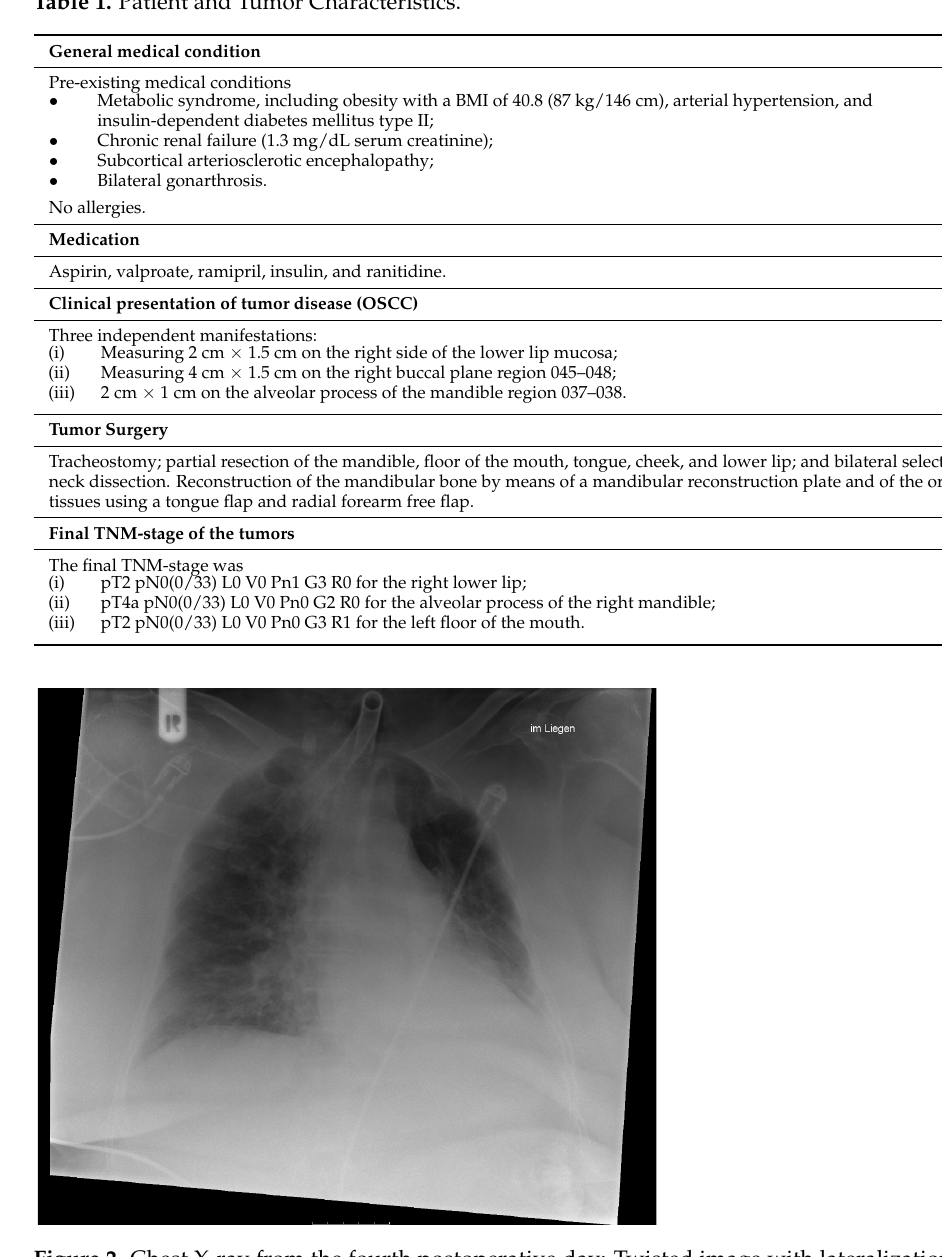
Figure 2. Chest X-ray from the fourth postoperative day: Twisted image with lateralization of the mediastinum to the left. Inserted tracheal cannula, the tip of which projects approximately 6.5 cm cranially to the carina onto the tracheal lightening band. The left dome of the diaphragm is not sharply delineated. Marked areal compression left-retrocardially. Prominent pulmonary hili on both sides as well as somewhat blurred vascular markings. In the supine position, no evidence of a pneumothorax. Assessment: Compaction retrocardially on the left side, consistent with a pneumonic infiltrate. Mild PV congestion. Table 2. Clinical Status and medical intervention Protocol; (P = prophylaxis, T = therapy, TID = 3 times daily).